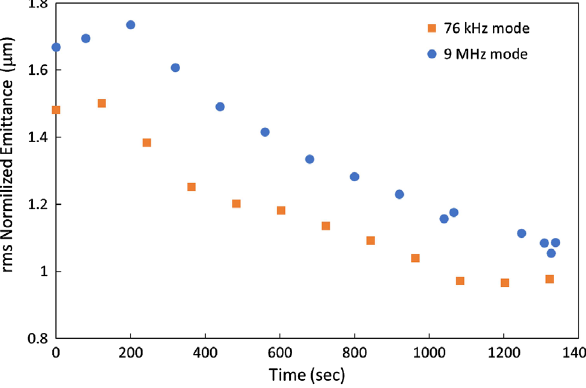
FIG. 13. Emittance reduction of a single RHIC ion bunch in the RHIC yellow ring as a result of LEReC providing cooling in the 76 kHz (orange) and in the 9 MHz (blue) modes. Cooling started around the 200 s mark.